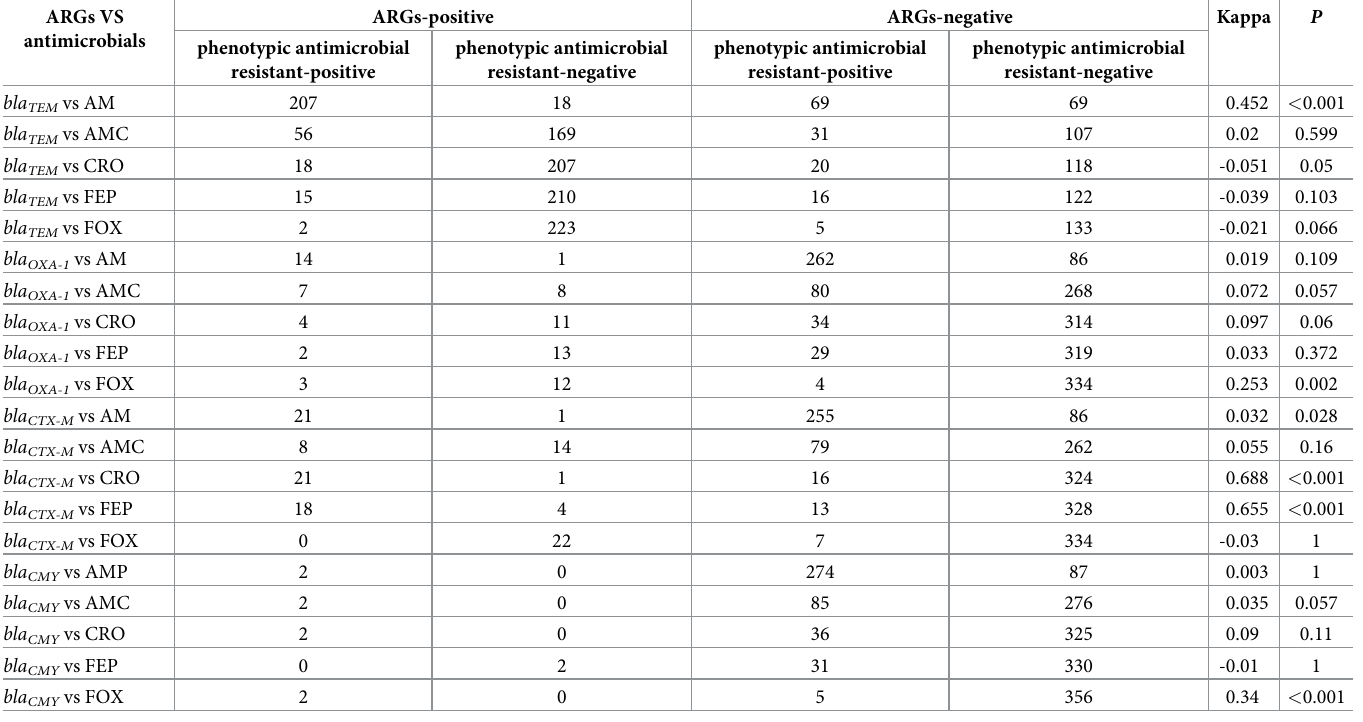
Table 5. The concordance between β -lactamase ARGs and phenotypic antimicrobial resistance of Salmonella isolates. ARGs VS